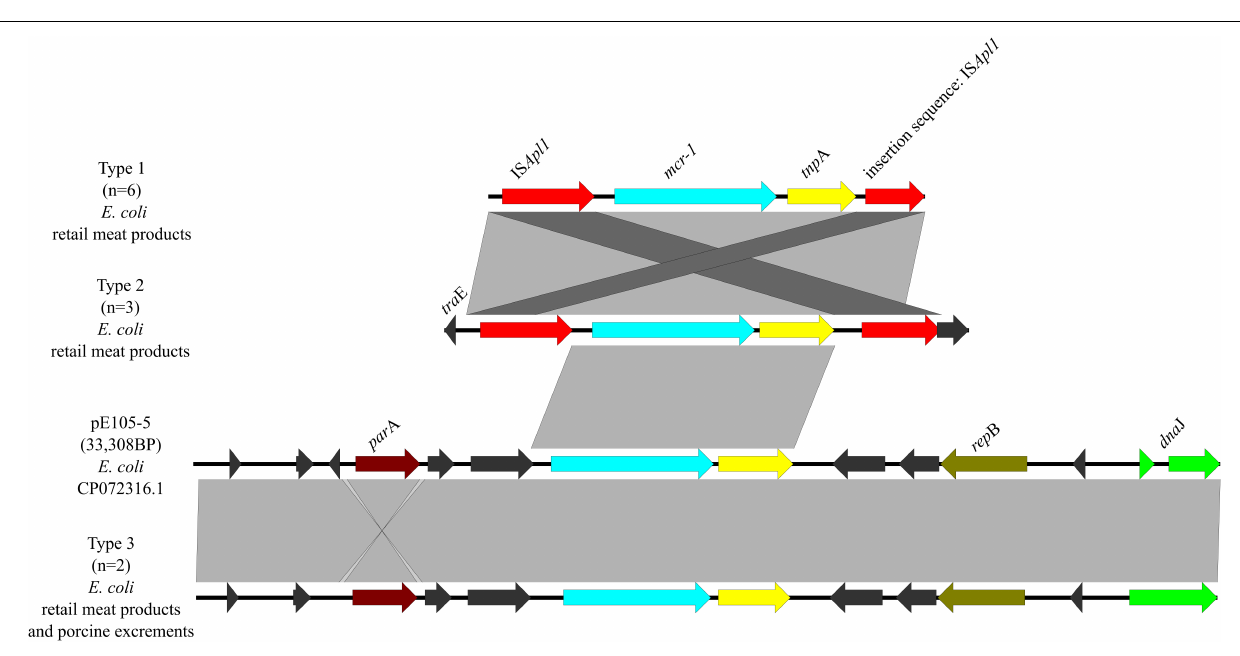
FIGURE 9 | Genetic environments of mcr-1 in plasmids. Arrows indicate the direction of transcription of the genes, and different colors indicate different genes. Regions of ≥ 99.0% nucleotide sequence identity are shaded